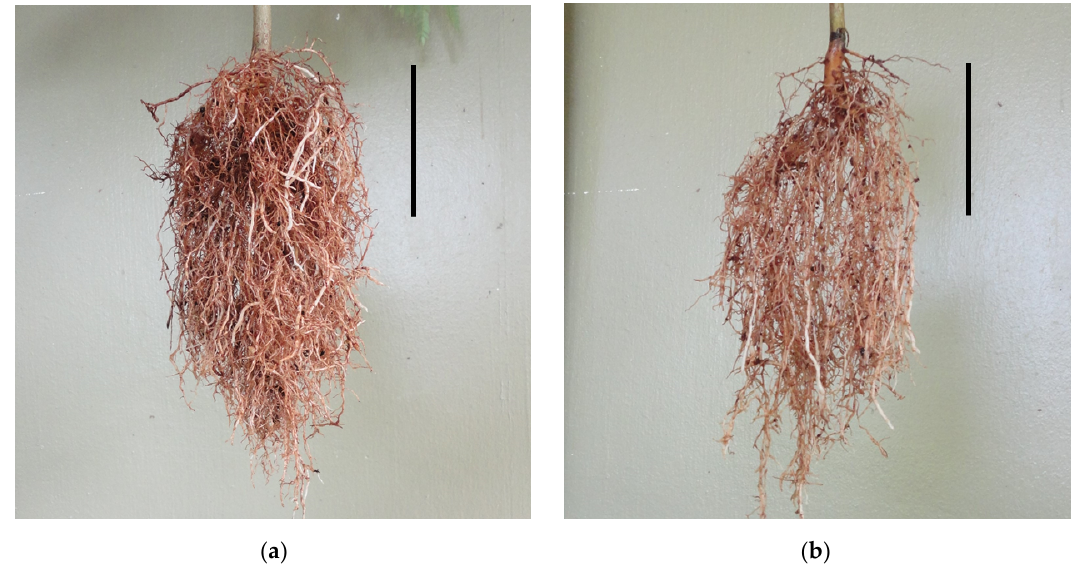
Figure 3. Appearance of Serianthes grandiflora roots after growing 10 months with ( a ) Nephrolepis hirsutula or ( b ) Serianthes grandiflora companion plants. Bars = 10 cm.